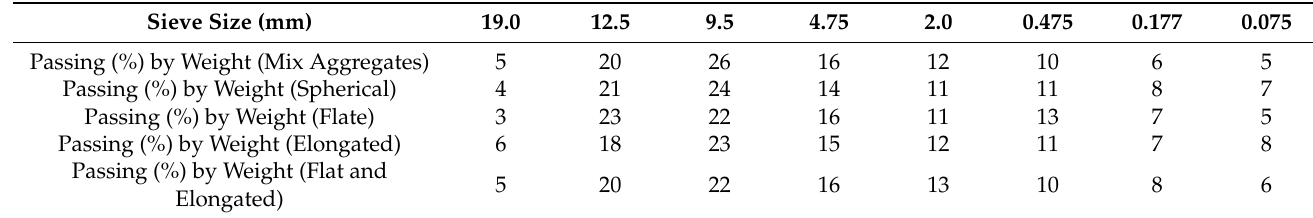
Table 3. Aggregate gradations for bituminous